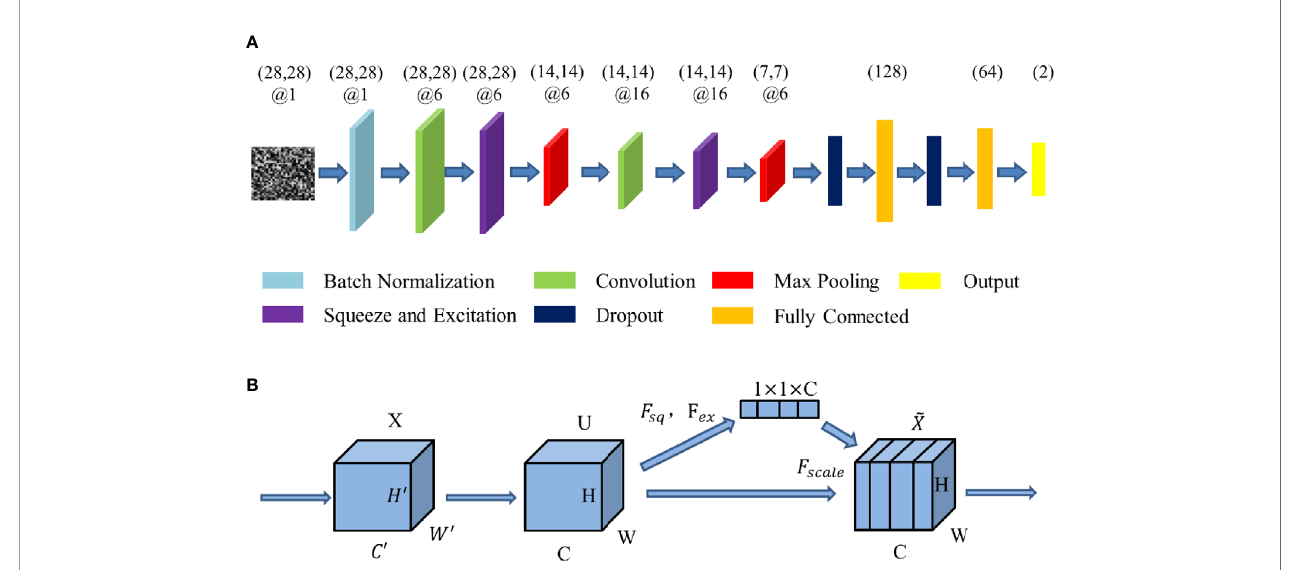
FIGURE 2 | The structure of the deep learning model. (A) The structure of SE-CNN. (B) The structure of Squeeze-and-Excitation (SE)